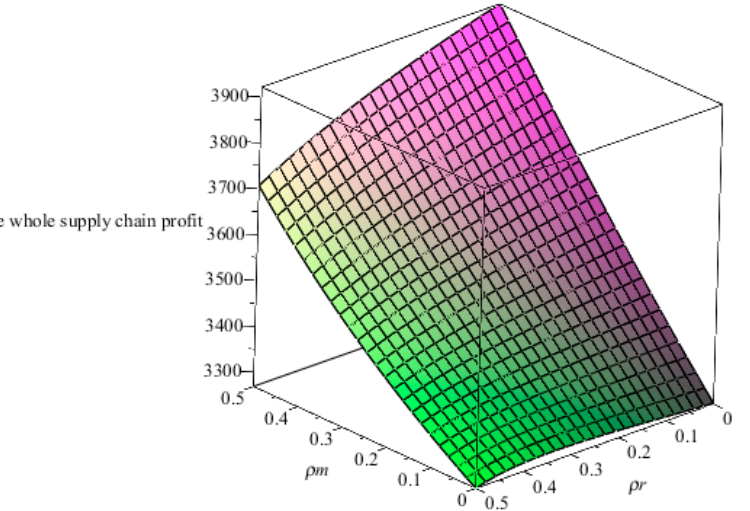
Figure 8. The relationship between the altruistic preference coefficients of two manufacturers and the retailer and the whole supply chain profit.